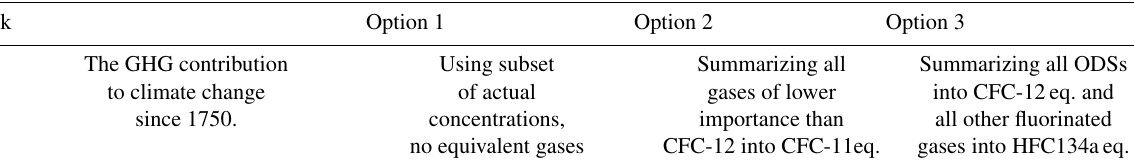
Table 5. Options for reducing the number of GHGs to be taken into account in climate models to approximate full radiative forcing of all GHGs. The GHGs are ranked by their radiative forcing, with CO 2 having the highest radiative effect change between 1750 and 2014. The stated percentages in this table’s rows are cumulative, i.e. the radiative forcing stated in a row is the radiative forcing of the GHG stated in that row plus the sum of all higher-ranked GHGs in the rows above, expressed as percentage of total anthropogenic GHG radiative forcing. In Option 1, a climate model explicitly resolves actual GHG concentrations. With 8 and 15 species, 99.1 and 99.7% of the total radiative effect can be captured, respectively. In Option 2, only CFC-12 is modelled next to CO 2 , CH 4 and N 2 O; all other gases are summarized in a CFC-11-equivalence concentration. In Option 3, all ODSs are summarized in a CFC-12-equivalence concentration, and all other fluorinated substances are summarized in HFC-134a-equivalence concentrations. Note that below shares are approximations, as linear radiative forcing efficiencies are assumed here for all gases, and also for CO 2 , N 2 O and CH 4